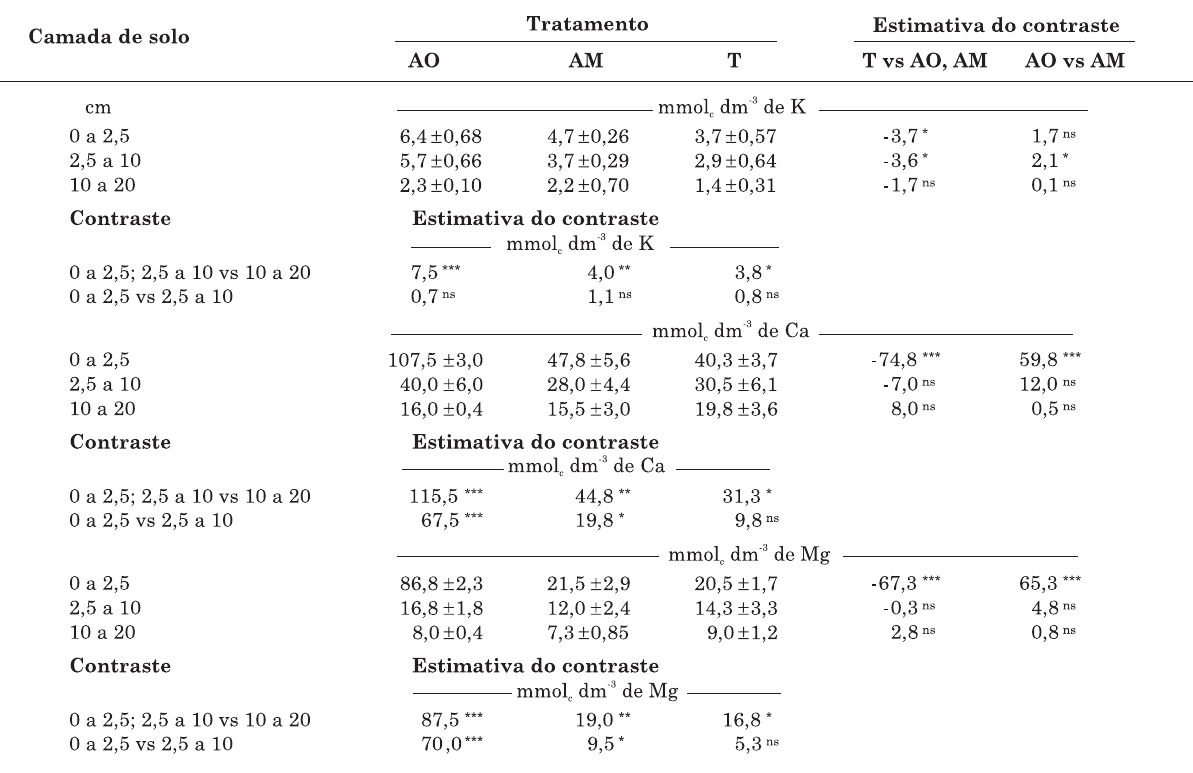
Quadro 5. Valores médios e estimativas dos contrastes das concentrações de K, Ca e Mg nas camadas de solo de 0 a 2,5 cm, 2,5 a 10 cm e 10 a 20 cm, após a percolação da água nos tratamentos adubo orgânico (AO), adubo mineral (AM) e testemunha